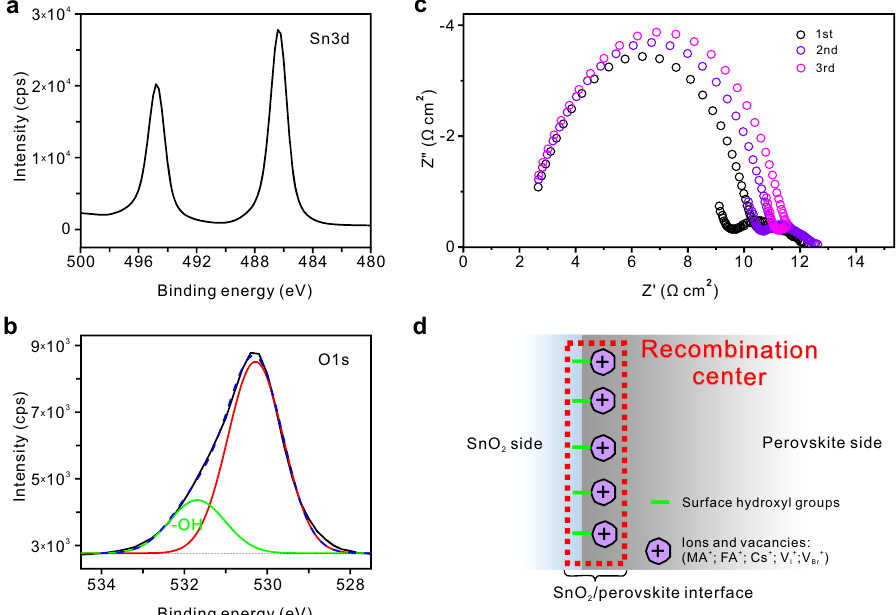
Fig. 2 Presence of surface charges on a SnO 2 surface induces ion accumulation and, therefore, increases carrier recombination in perovskite solar cells. a , b X-ray photoelectron spectroscopy peaks of a SnO 2 thin fi lm in the Sn 3 d ( a ) and O 1 s ( b ) regions. c Electrochemical impedance spectroscopy results of perovskite solar cells. The electrochemical impedance spectroscopy measurements were repeated three times. d Illustration showing the positive ion localization caused by the surface-negative charges ( – OH) of SnO 2 . The possible mobile positive ions are MA + (methylammonium ion), FA + (formamidinium ion), V I + (iodine vacancy), and V Br + (bromine